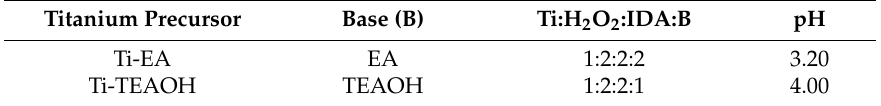
Table 1. Stable titanium precursor solutions with different bases and molar ratios to